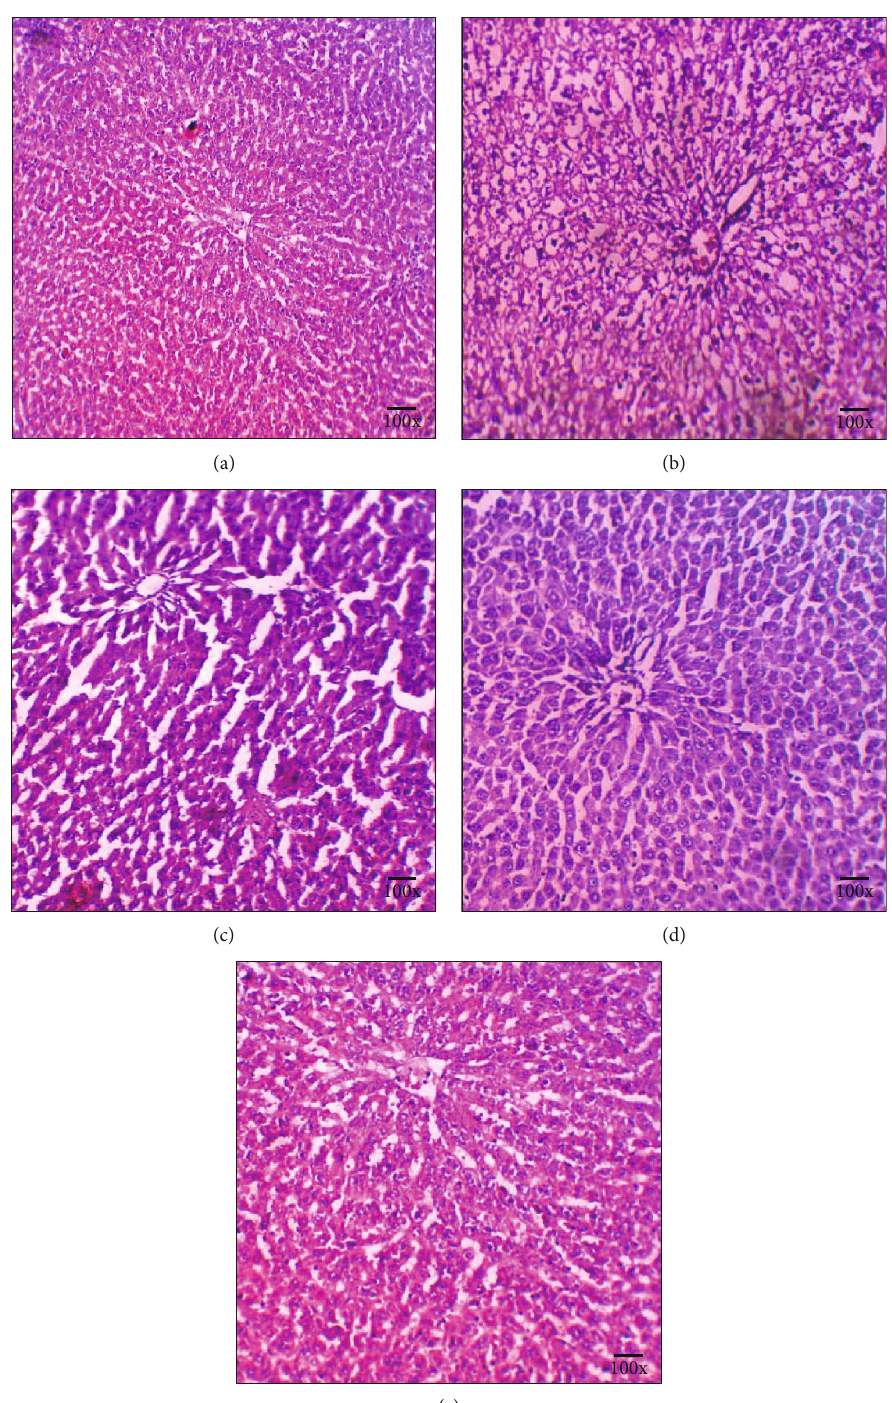
Figure 3: Probiotic V and Met alone or in combination regulates the lipid accumulation in the liver to prevent ethanol-induced hepatic injury. Histological examination of liver sections stained with hematoxylin and eosin (100x magni fi cation) of (a) control, (b) ethanol-fed, (c) Met (75 mg/kg)+ethanol-fed, (d) probiotic V (10 8 CFU/day)+ethanol-fed, and (e) probiotic V (10 8 CFU/day)+Met (75 mg/kg)+ethanol- fed